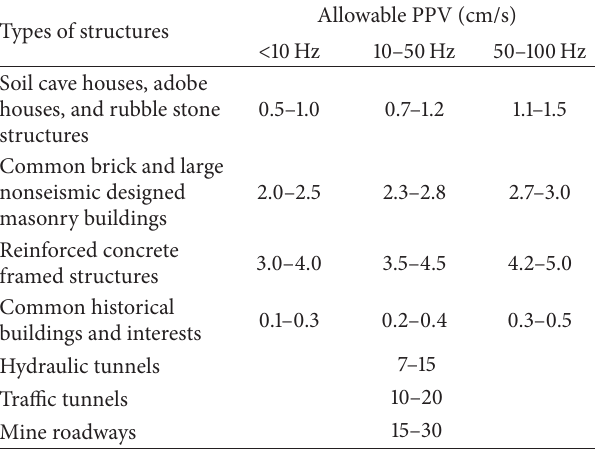
Table 3: The safe level standard of blast vibrations in China